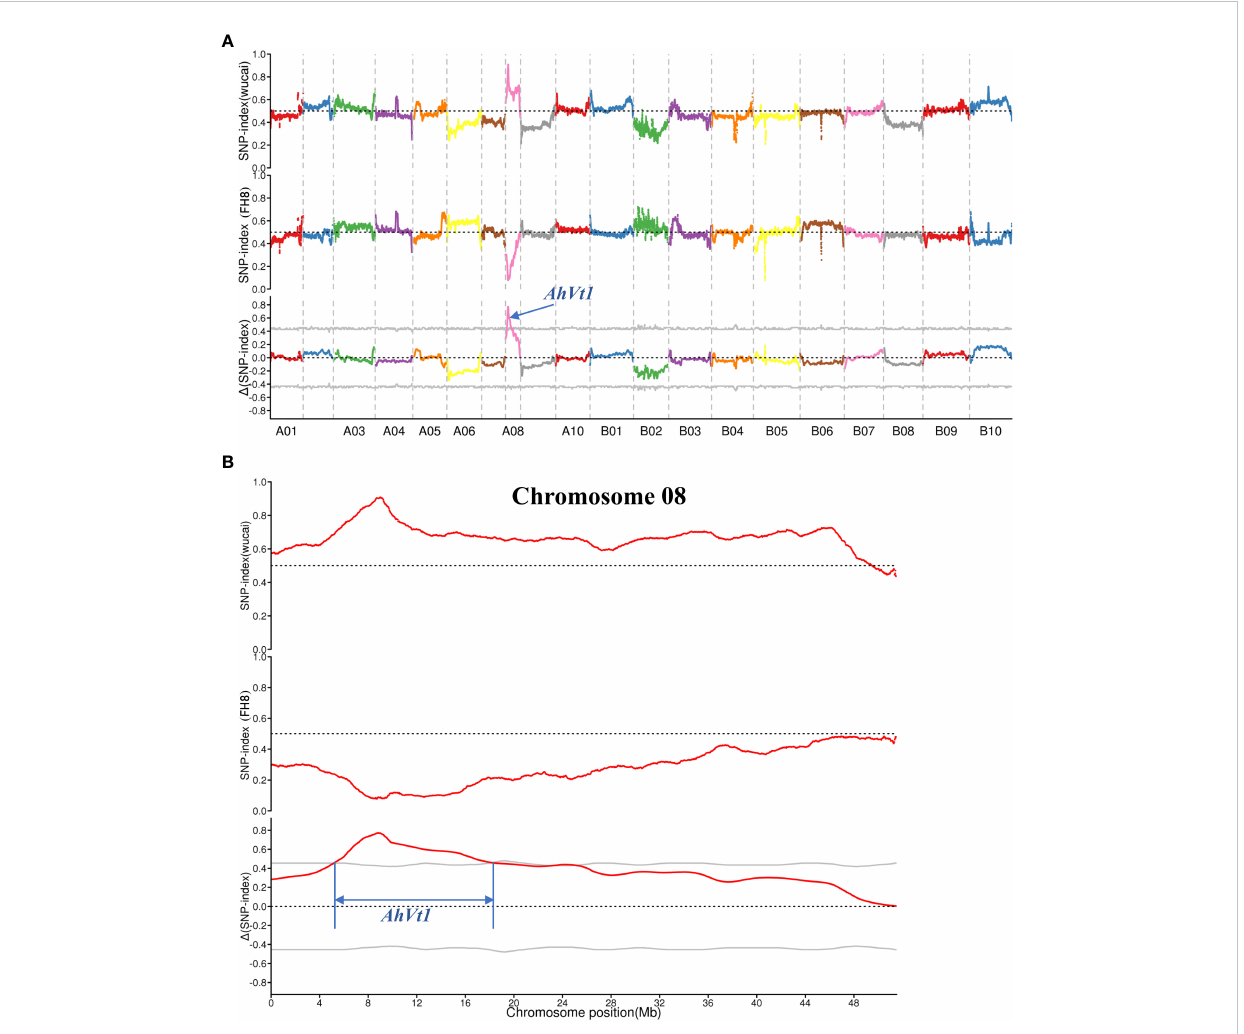
FIGURE 4 Mapping of locus responsible for variegated testa by BSA-seq strategy. (A) . SNP and D SNP index of the Pure Testa Bulk (PTB) and Variegated Testa Bulk (VTB) in the whole genome-wide scale. (B) . Preliminary mapping of AhVt1 in chromosome 08. The gray lines indicate the threshold value. The preliminary mapping region of AhVt1 was limited by two blue lines.